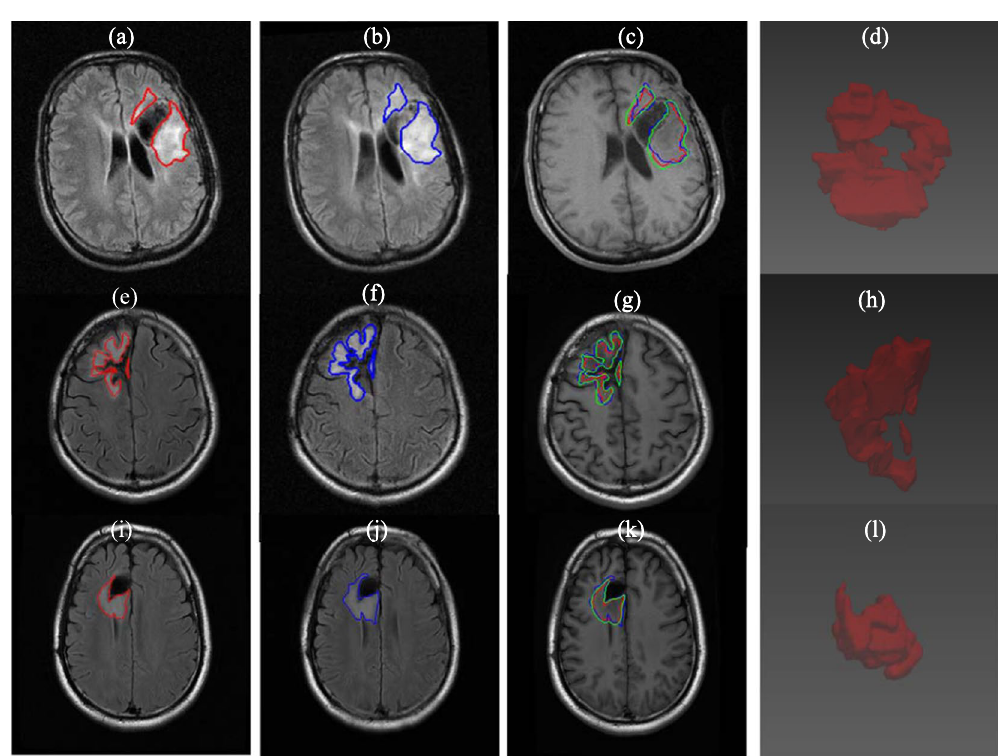
Figure 6. Simulation results of tumor growth from 3 LGG patients who underwent surgery followed by chemotherapy. The red ( a , e , i ) and blue ( b , f , j ) contours represent the ground truths of tumor boundaries on2 serial T2 MR images while the green contours ( c , g , k ) are the simulated growths on T1 MR images. ( d ), ( h ), and ( l ) are constructed 3D views of the simulated tumor